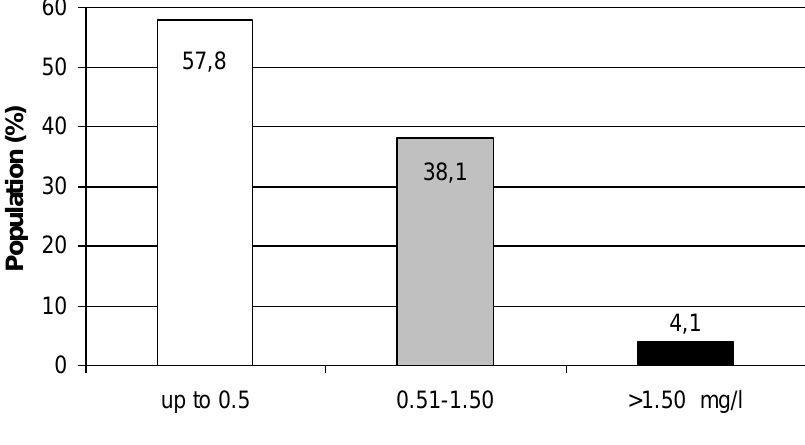
Figure 2. Distribution of population exposed to different fluoride levels in drinking